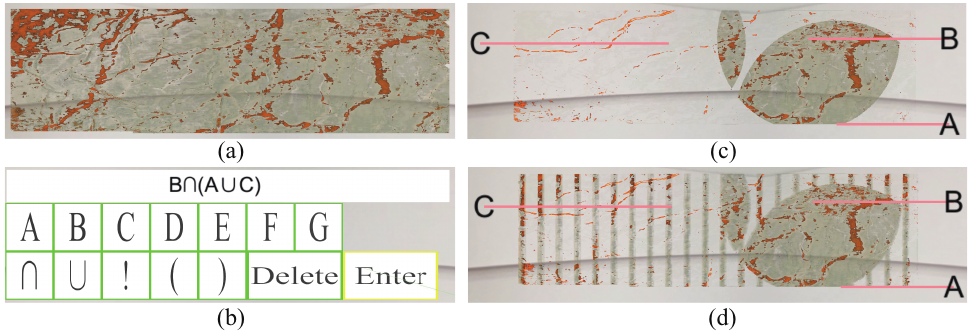
Figure 8. ( a ) The overall Dataset II is rendered on GPU by volume rendering. ( b ) The user inputs the set operation expression B ∩ (A ∪ C) into the virtual keyboard. ( c ) The result of B ∩ (A ∪ C) query in Dataset II. ( d ) The combination of the cross-shaped display mode and the extracted stratigraphic